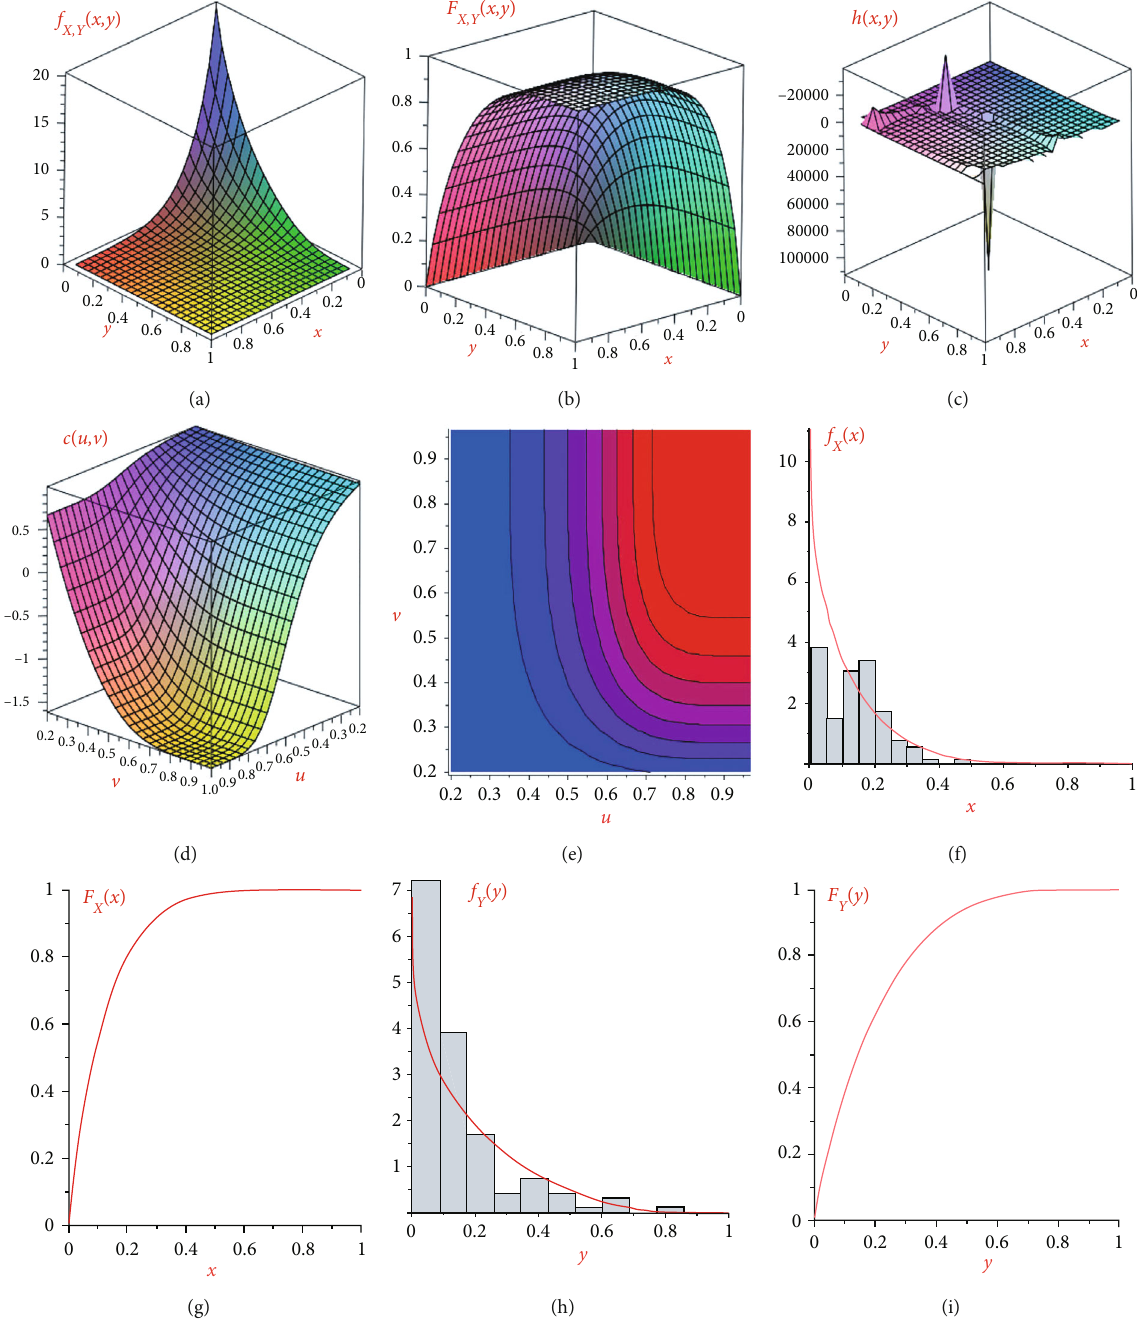
Figure 18: Statistical quantities of the random variable ð X , Y Þ ~ BIUPW at